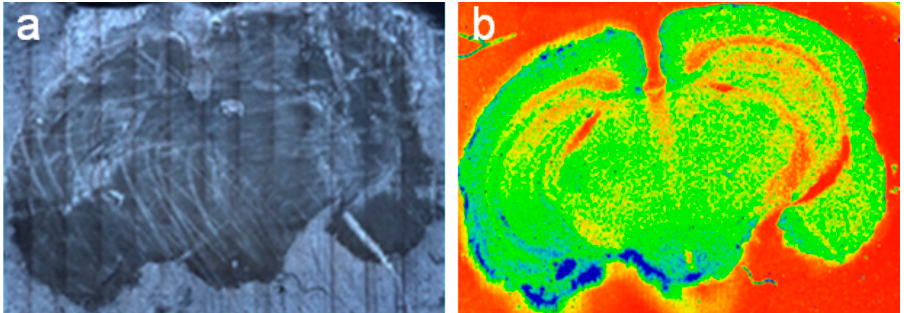
Figure 7. Raman image of a mouse brain tissue section: ( a ) “mosaic” optical image captured with 20× objective; ( b ) color-coded Raman image of 9 × 6 mm 2 showing variation in the overall intensity of Raman spectra that corresponds to diverse macrostructural as well as microstructural anatomical regions of the brain. Measurement parameters: 24 mW of the 780 nm laser power at the sample, 50 µm confocal pinhole, 25 µm image pixel, 86,994 spectra, 2.5 h total collect time.